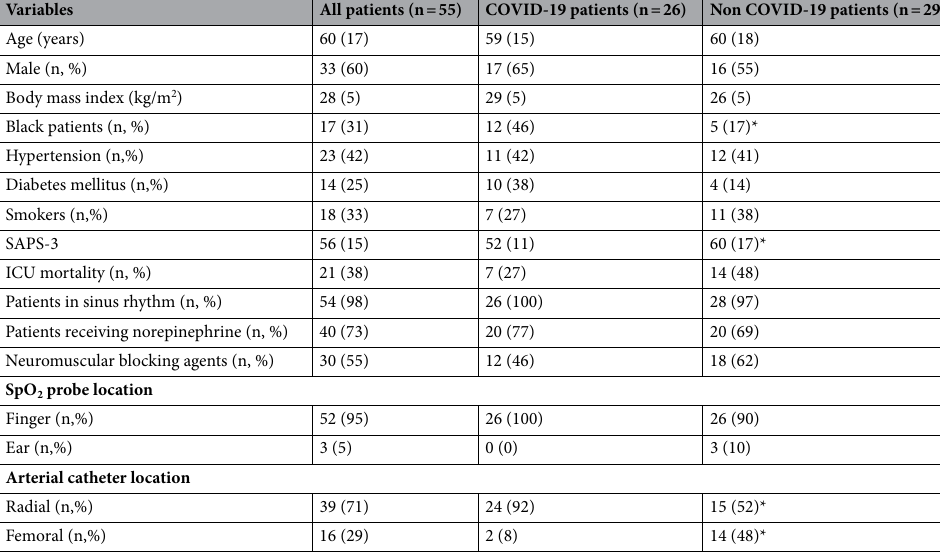
Table 1. Patient characteristics. Variables are expressed as mean (standard deviation) or counts (percentages). ICU Intensive Care Unit, SAPS Simplified Acute Physiology Score, SpO 2 pulse oximetry. * p < 0.05 non- COVID-19 versus COVID-19